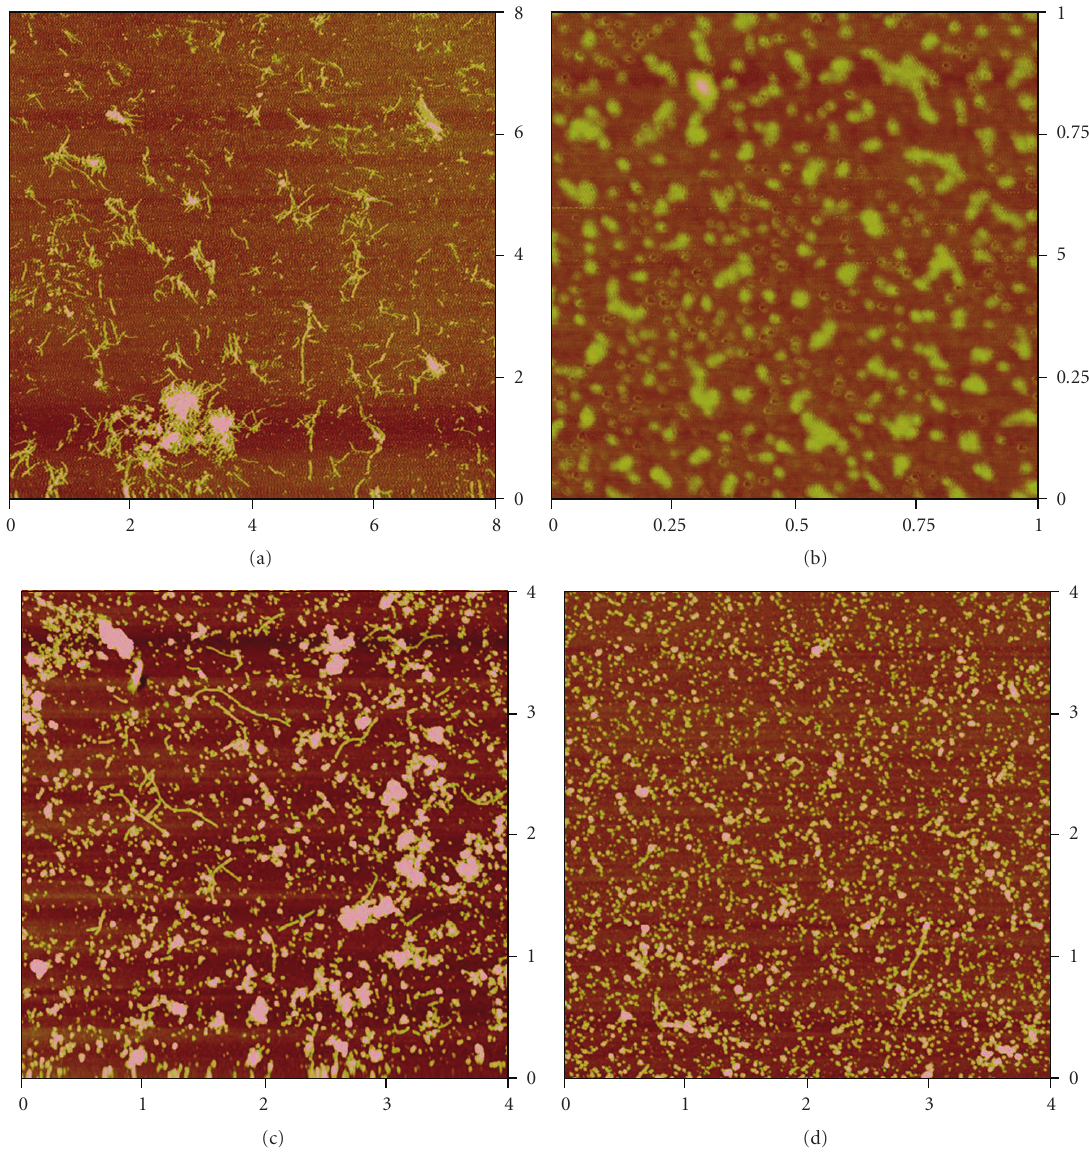
Figure 7: AFM images: (a) A β (1–42) in PBS bu ff er (pH 7.4), 8 μ m × 8 μ m; (b) DHLA-capped QDs, 1 μ m × 1 μ m; (c) A β (1–42) mixed with DHLA-capped QDs in PBS bu ff er (pH 7.4), 4 μ m × 4 μ m; (d) A β (1–42) conjugated to DHLA-capped QDs in PBS bu ff er (pH 7.4), 4 μ m × 4 μ